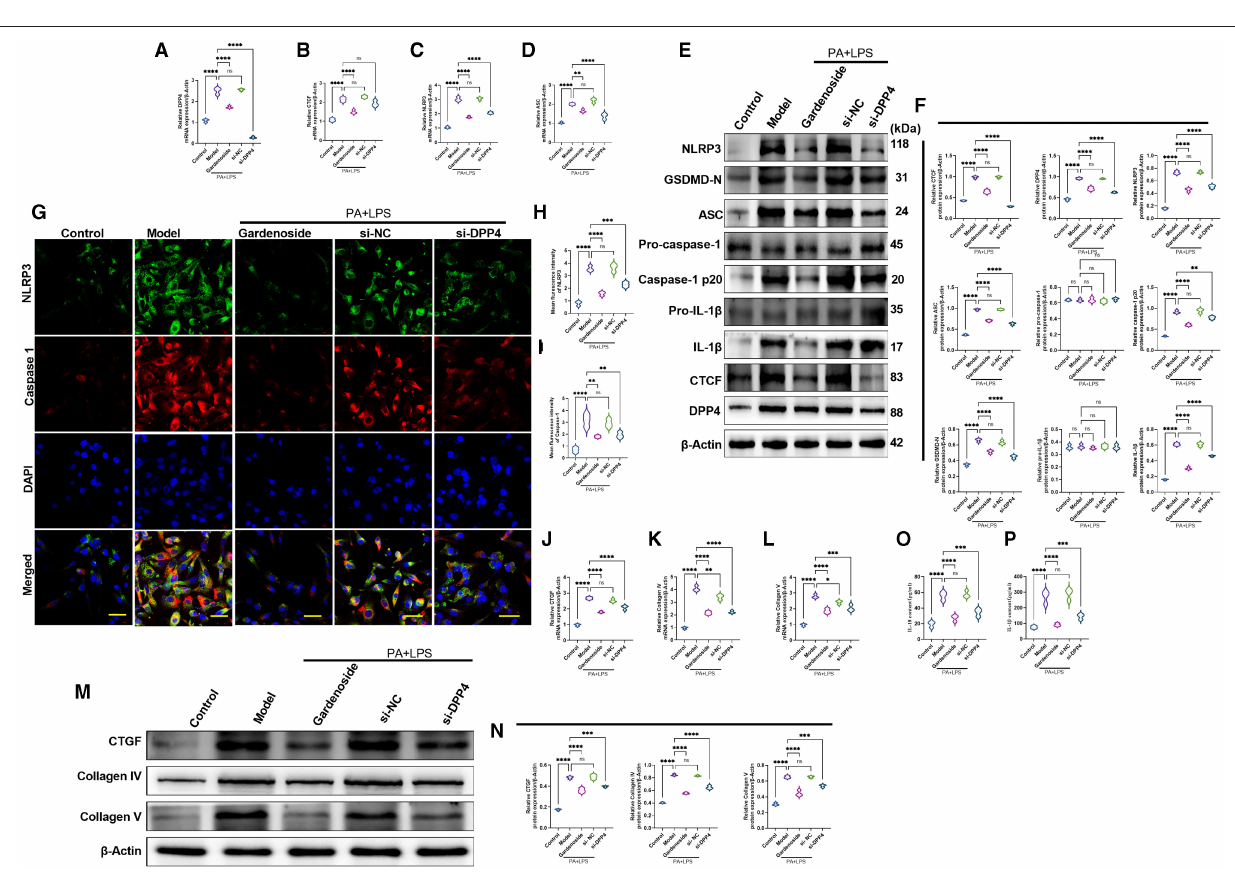
FIGURE 8 | DPP4 silencing mimicked the effect of gardenoside on the activation of the NLRP3 inflammasome, caspase1-induced pyroptosis and fibrosis pathways in hepatocytes. (A) RT-qPCR detection of the relative mRNA expression of DPP4 in AML cells in indicated groups. (B) RT-PCR detection of the relative mRNA expression of CTCF in AML cells in indicated groups. (C) RT-PCR detection of the relative mRNA expression of NLRP3 in AML cells in indicated groups. (D) RT-PCR detection of the relative mRNA expression of ASC in AML cells in indicated groups. (E) Representative bands of Western blot detection of the relative protein expression of CTCF, DPP4, NLRP3, ASC pro-caspase-1 p20, caspase-1 p20, GSDMD-N, pro-IL-1 β , and IL-1 β in AML cells in indicated groups. (F) Densitometry analysis of bands of Western blot detection of the relative protein expression of CTCF, DPP4, NLRP3, ASC pro-caspase-1 p20, caspase-1 p20, GSDMD-N, pro-IL-1 β , and IL-1 β in AML cells in indicated groups. (G) Representative images of immunofluorescence analysis of NLRP3 and Caspase-1 expression in AML cells in indicated groups (Scale bar: 50 µ m). (H) Quantification of immunofluorescence intensity of NLRP3 expression in different groups as determined by immunofluorescence analysis. (I) Quantification of immunofluorescence intensity of Caspase-1 expression in different groups as determined by immunofluorescence analysis. (J) RT-qPCR detection of the relative mRNA expression of the fibrosis marker CTGF in AML cells in indicated groups. (K) RT-qPCR detection of the relative mRNA expression of the fibrosis marker Collagen IV in AML cells in indicated groups. (L) RT-qPCR detection of the relative mRNA expression of the fibrosis marker Collagen V in AML cells in indicated groups. (M) Bands of Western blot detection of the relative protein expression of the fibrosis markers CTGF, Collagen IV, and Collagen V in AML cells in indicated groups. (N) Densitometry analysis of bands of Western blot detection of the relative protein expression of the fibrosis markers CTGF, Collagen IV, and Collagen V in AML cells in indicated groups. (O) ELISA detection of the protein level of IL-18 in indicated groups. (P) ELISA detection of the protein level of IL-1 β in indicated groups. ns, non-significant, * p < 0.05, ** p < 0.01, *** p < 0.001, and **** p < 0.0001 in the comparison between the indicated groups.